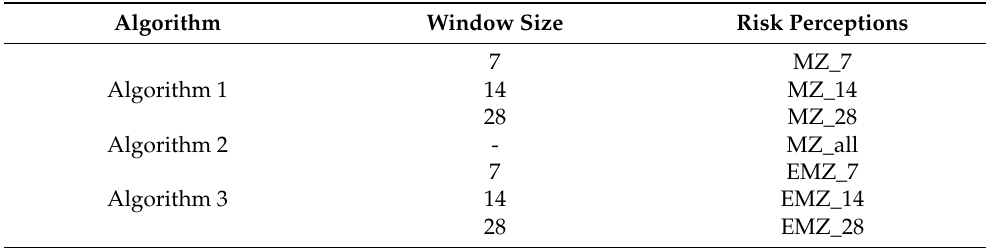
Table A1. The risk perceptions to examine in the case study (mz: moving z-score; emz: exponentially weighted moving z-score).